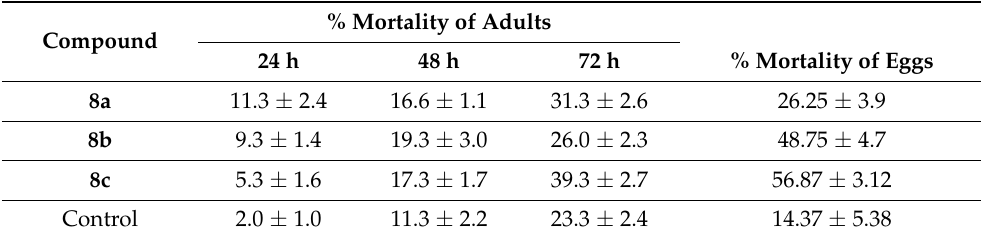
Table 4. Means ± standard error of the mortality of adults and eggs of T. urticae treated with compounds 8a – c .